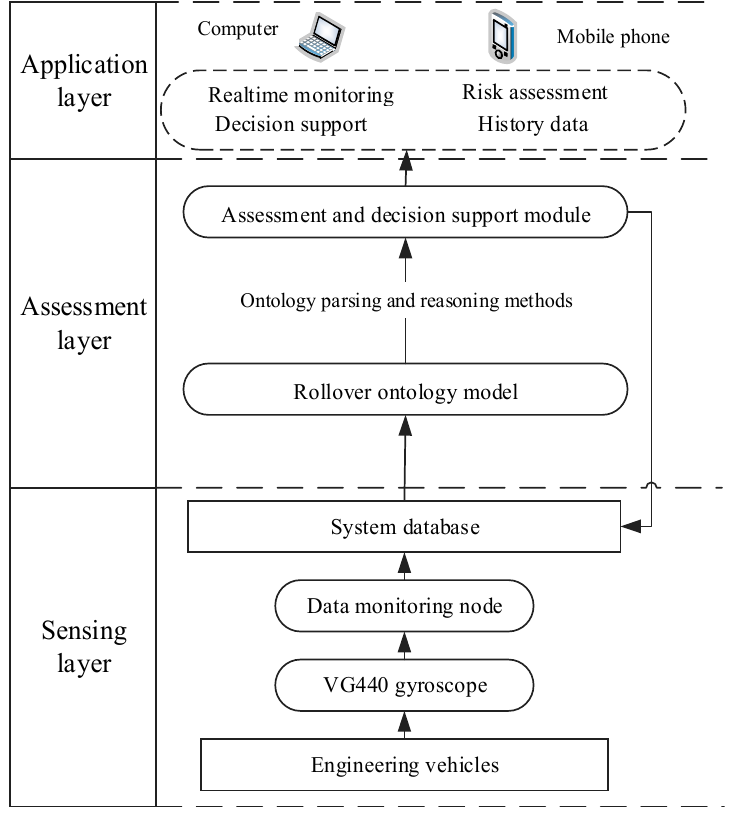
Figure 1. The framework of rollover monitoring and decision support system.